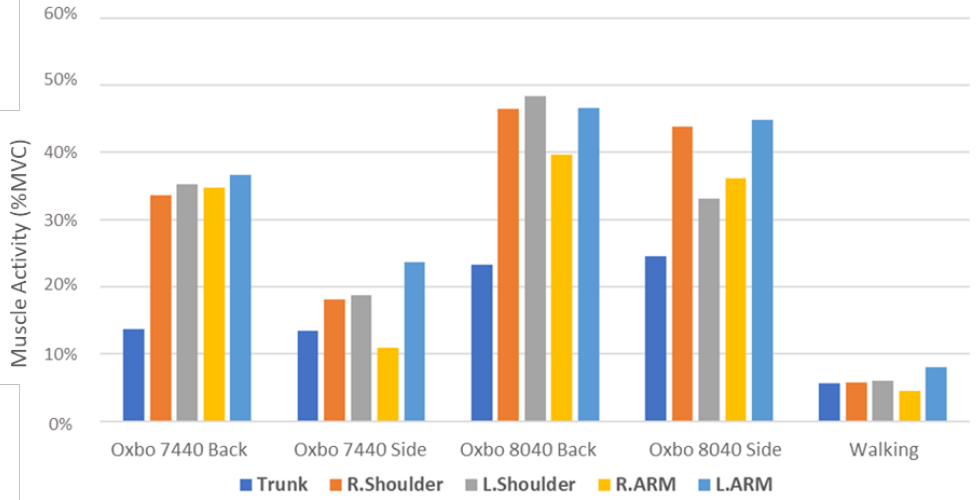
Figure 11. Muscle activity of five body regions by working condition (R.: Right; L.: Left).